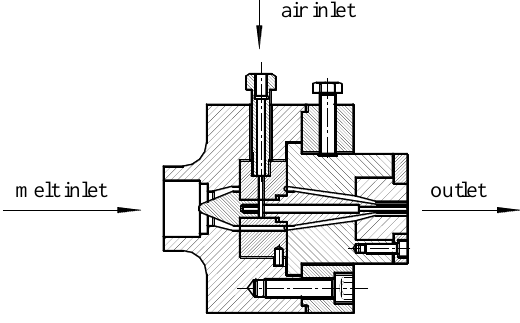
Figure 3. The in-line extrusion die structure for micro tubes.